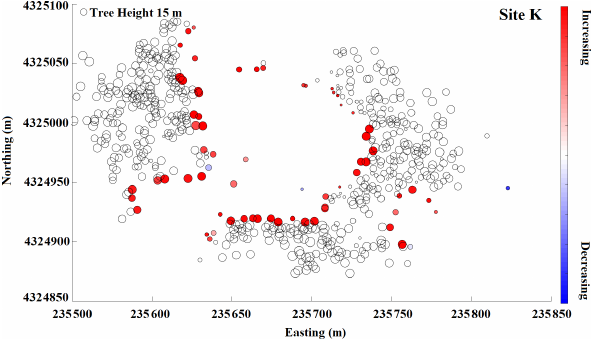
Figure B6. Snow depth change within a 10m buffer from the edge of a tree at site K. Red color indicates snow depth increases moving from the tree edge toward the open areas, and blue indicates snow depth decreases. Increasing and decreasing patterns are shown for individual trees at each site with adequate snow coverage.